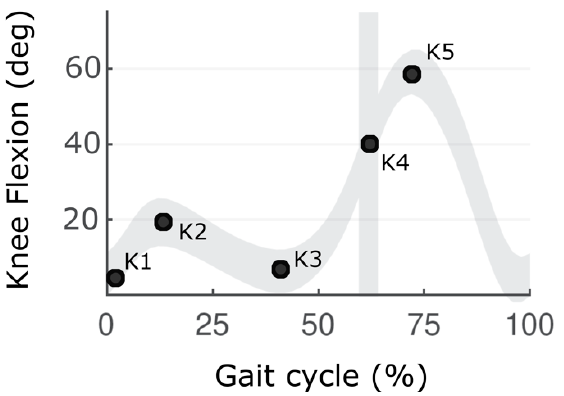
Figure 1. Knee kinematics in sagittal plane. [K1] Knee position at initial contact; [K2] maximum knee flexion at initial stance; [K3] Minimum knee position during terminal stance; [K4] Knee position at toe off; [K5] Maximum knee flexion during swing